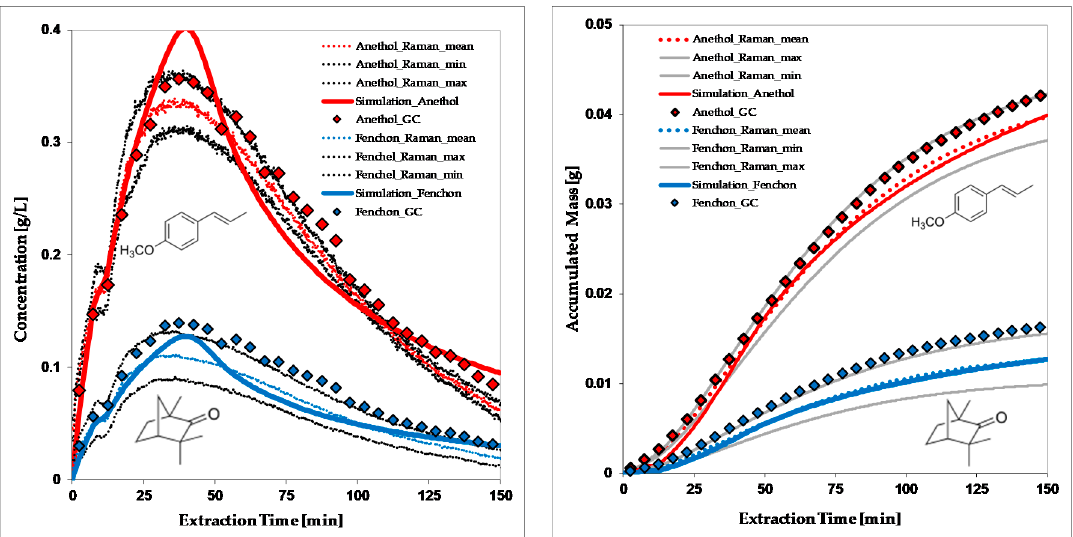
Figure 16. Concentration measurement by raman spectroscopy of anethol (dark grey) and fenchone (light grey) during extraction [44].